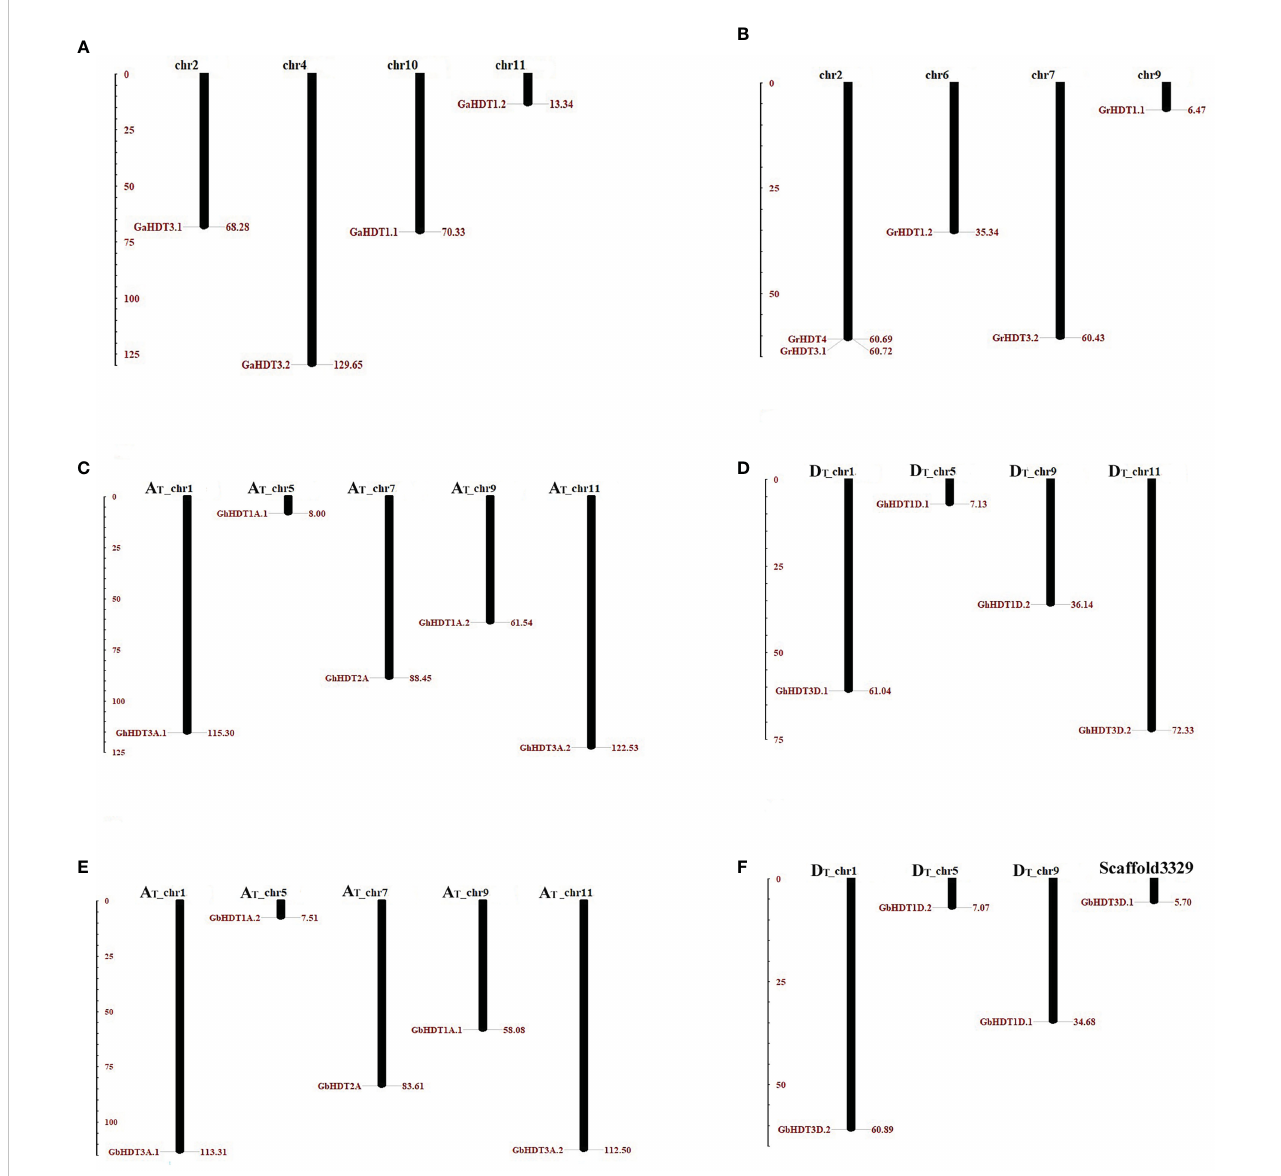
FIGURE 6 Chromosomal localization of HD2 family genes in the Gossypium genome. In this physical mapping, the positions of HD2 members on A, D, and AD genomes are illustrated separately. HD2 genes are indicated by red-brown lines on Gossypium chromosomes, and the number of the chromosome depicted is provided at the top. (A, B) The distribution of HD2 genes in the G. arboreum and G. raimondii genomes. (C, D) The arrangement of HD2 genes in the G. hirsutum genome; (E, F) The distribution HD2 genes in the G. barbadense genome. The scale is measured in mega bases